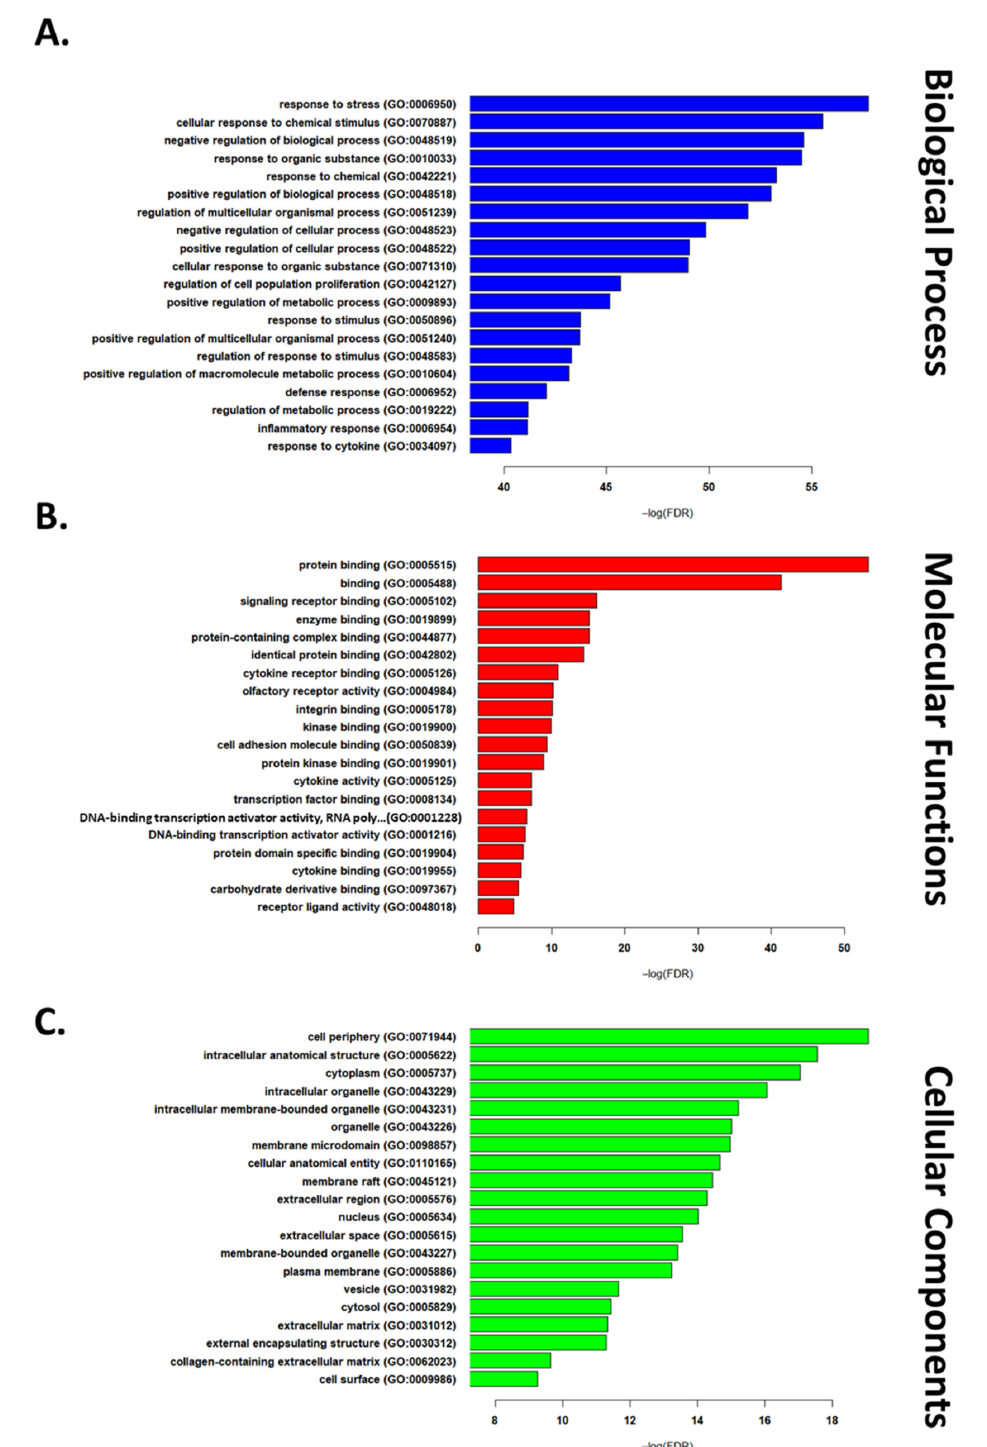
Figure 1. The top 20 GO terms in each of the biological process ( A ), cellular components ( B ), and molecular functions ( C ) domains for upregulated genes (list of all significant terms can be found in Table S6–S8).